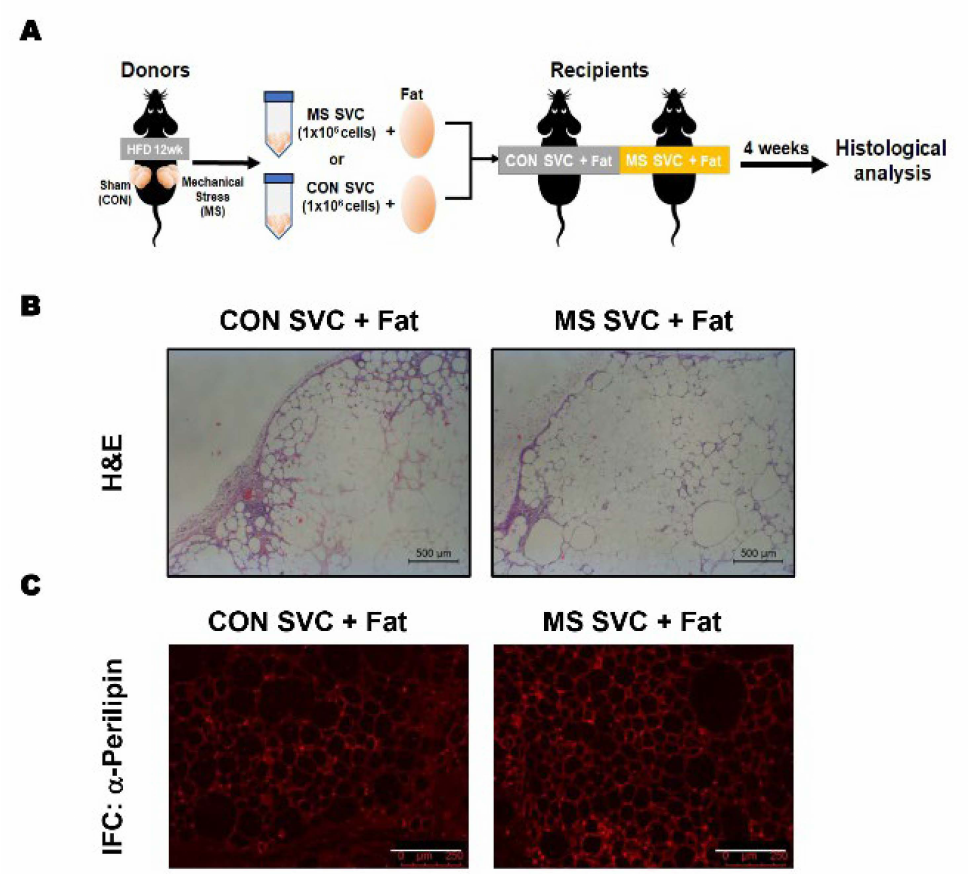
Figure 4. Histological analysis of fat grafts supplemented with SVC from adipose tissue treated with mechanical stress. CAL with SVC obtained from the donor site after surgical preconditioning procedure was performed to examine the efficacy of the obtained SVC ( n = 6 per group); ( A ) Schematic diagram of experimental design; ( B ) H&E staining (4 × magnification); ( C ) Representative immunohistological staining of Perilipin (10 ×